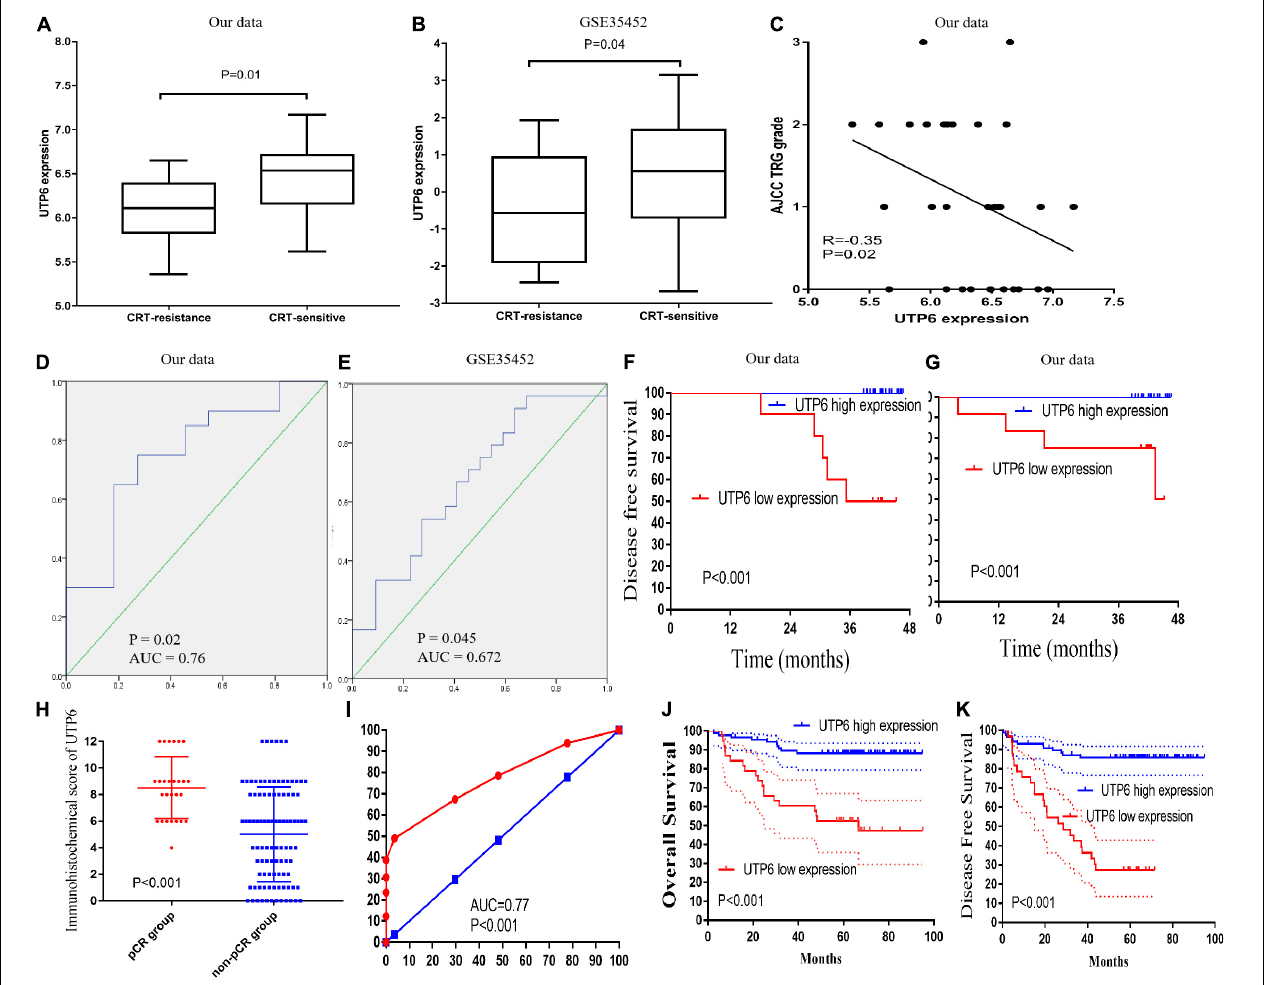
FIGURE 4 | Validation of UTP6. (A) In our data (6.46 ± 0.40 vs. 6.07 ± 0.40, P = 0.02) and (B) GSE35452 (0.45 ± 1.51 vs. –0.47 ± 1.45, P = 0.042). (C) Pearson’s correlation analysis between the AJCC TRG grade and UTP6 expression. ROC curves and AUC statistics to evaluate the predictive efficiency of the UTP6 in our data and external data to distinguish CRT-resistance from CRT-sensitive CRC cases from (D) our data and (E) GSE35452. The disease-free survival (F) and overall survival (G) between low and high expression of UTP6. (H) UTP6 expression in the pCR and non-pCR group in the LARC patients’ sample. (I) ROC curves and AUC statistics to evaluate the predictive efficiency of the UTP6 in LARC patients’ samples to distinguish pCR from non-pCR LARC cases. The overall survival (J) and disease-free survival (K) between low and high expression of UTP6 in LARC patients’